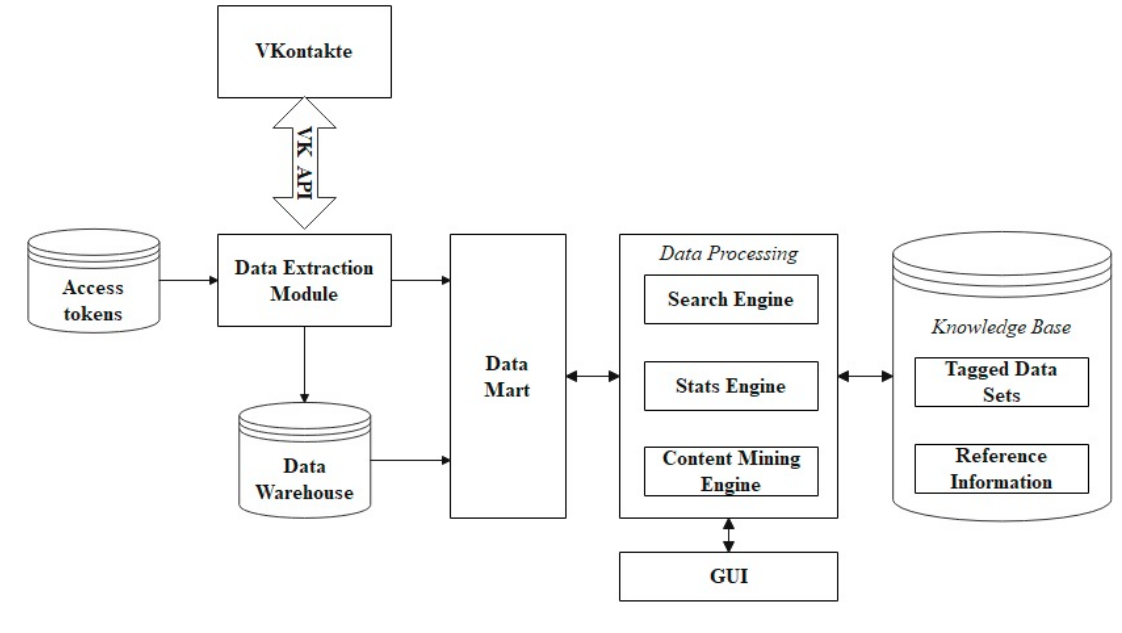
Figure 1. Software architecture for automated detection of far-right communities in the social network VKontakte.